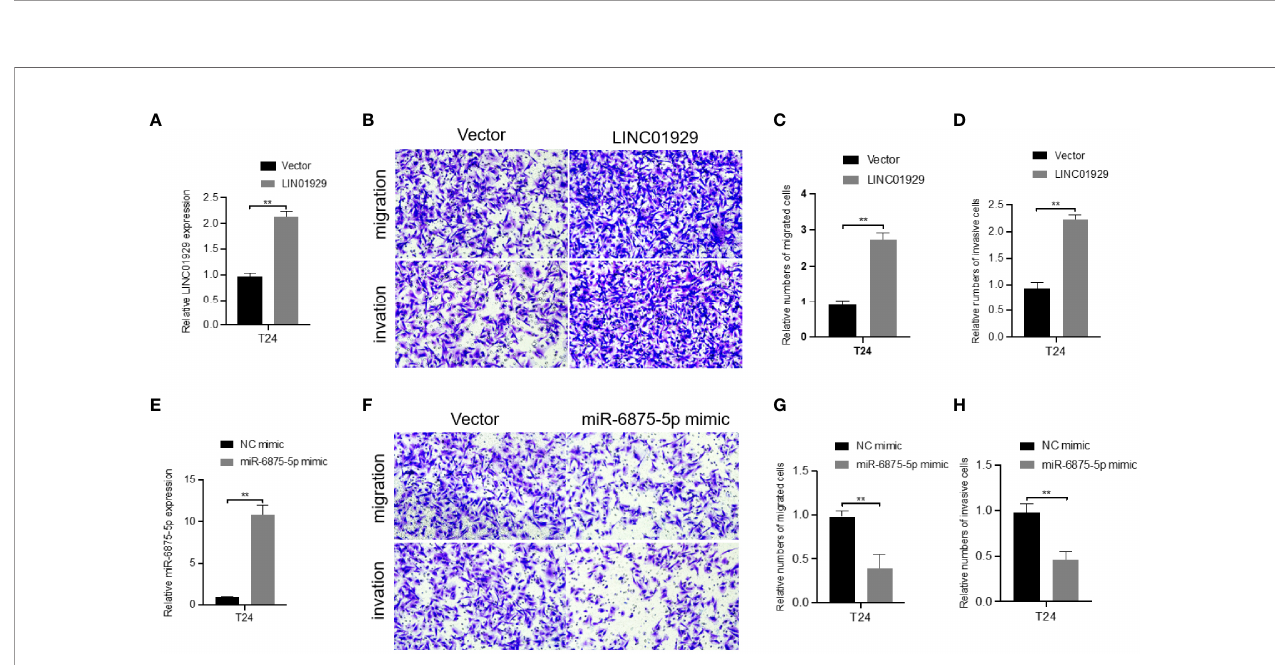
FIGURE 9 | Effect of overexpression of LINC01929 and miR-6875-5p on T24 cells. (A) Validation of the effect of LINC01929 overexpression at the RNA level in T24 cells. Transwell assays (B) show that overexpression of LINC01929 enhances cell invasion. (E) Validation of the overexpression effect of miR-6875-5p at the RNA level in T24 cells. Transwell assays (F) show that overexpression of miR-6875-5p attenuates cell invasion. (C, G) Relative numbers of migrated cells. (D, H) Relative numbers of invasive cells. **P <